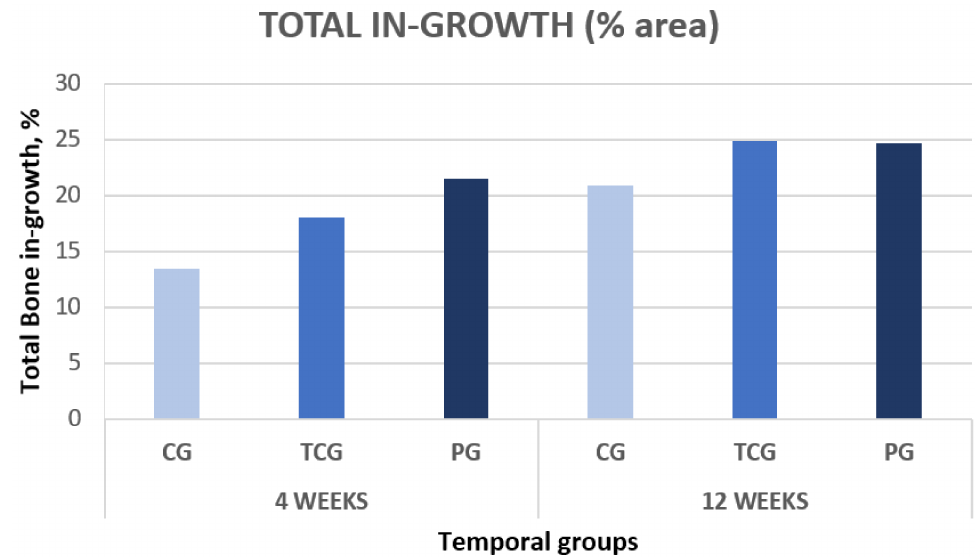
Figure 4. Total new bone formation in titanium porous foam 4 and 12 weeks after